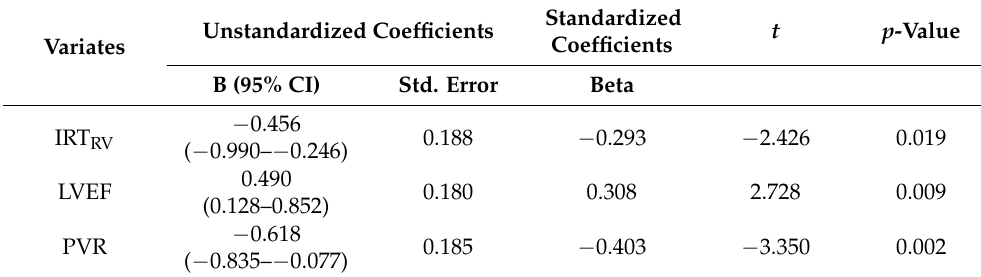
Table 5. Multiple linear regression analysis for